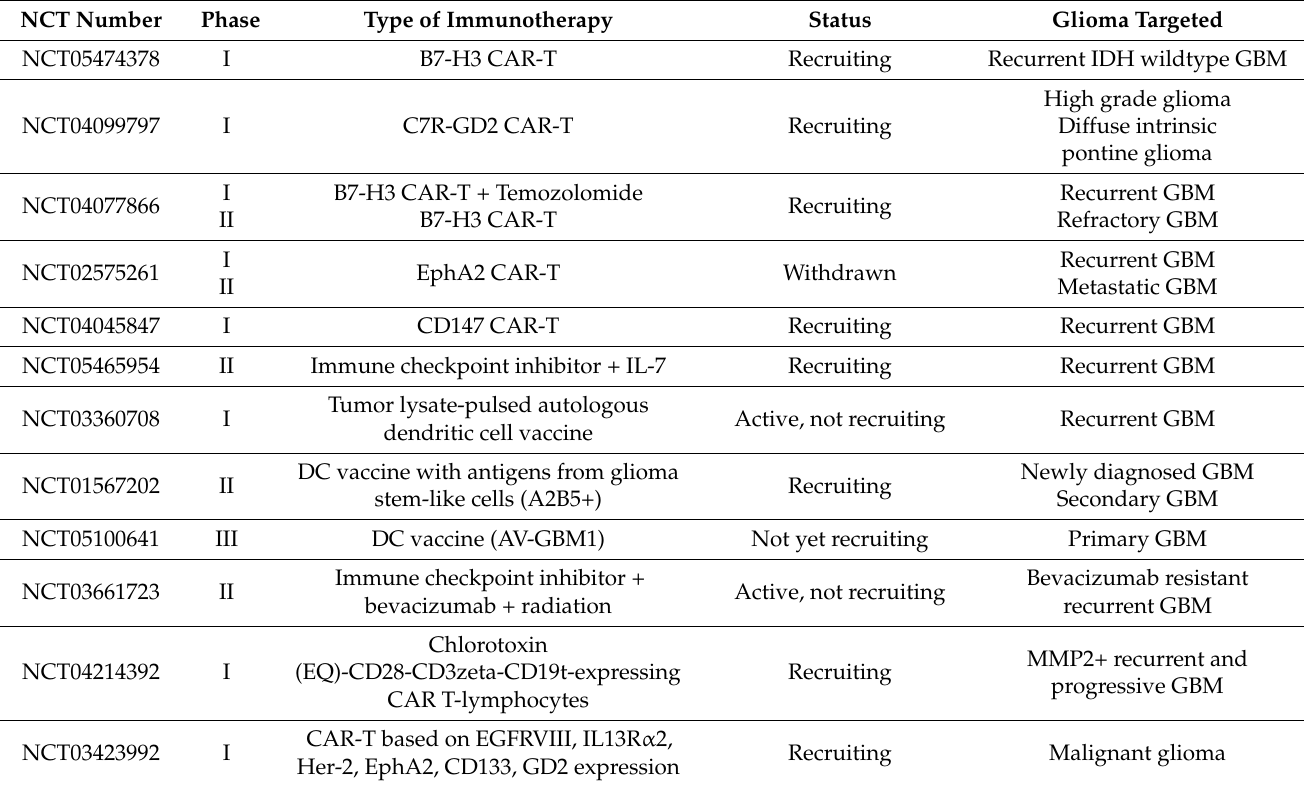
Table 3. Ongoing clinical trials for GBM employing